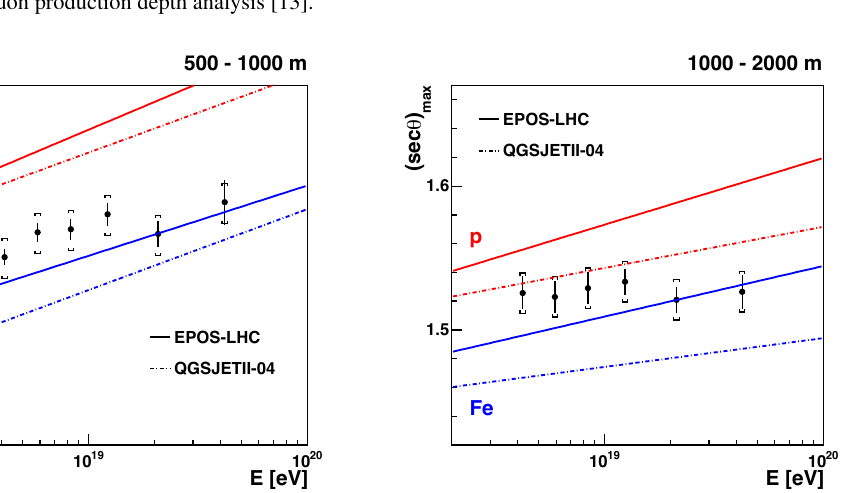
Figure 3. Results of the muon production depth analysis [13].